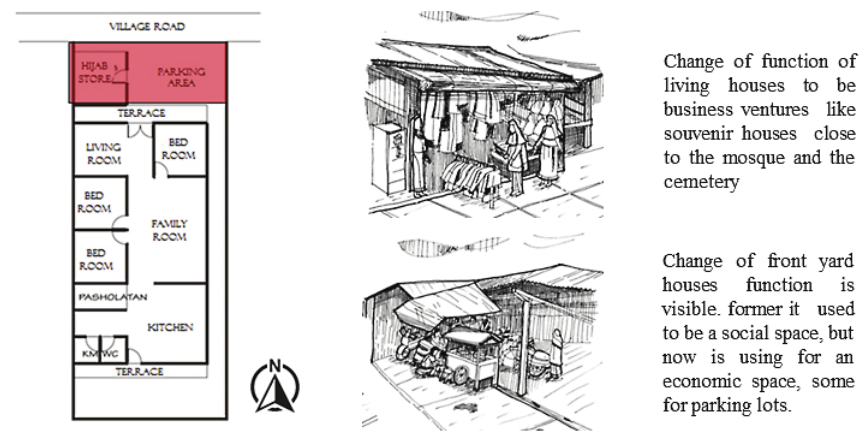
Figure 13. The change of houses function into economic space (source: Survey,